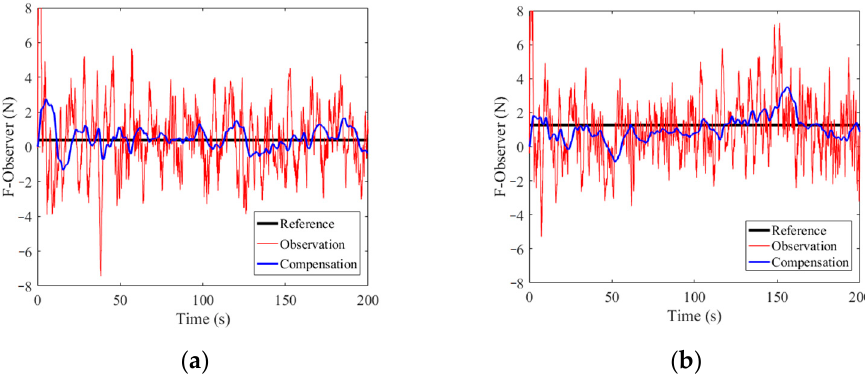
Figure 17. The observed values of the extended state observer (ESO) under two different velocity disturbances. ( a ) Observer at u = 0.1 m/s, v = 0.1 m/s; ( b ) Observer at u = 0.2 m/s, v = 0.2 m/s.